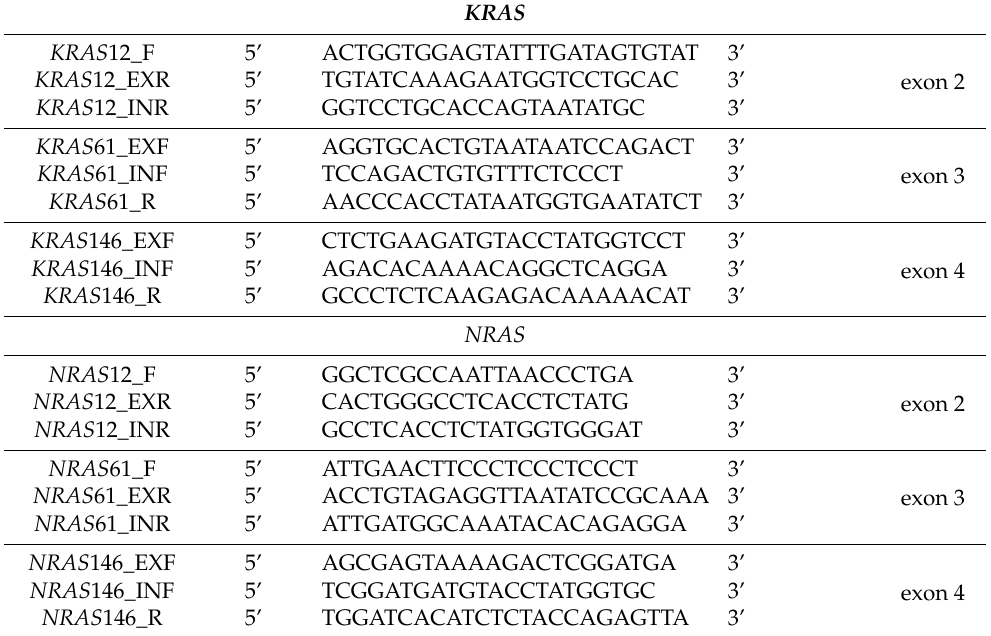
Table 1. Sequences of primer sets used for each